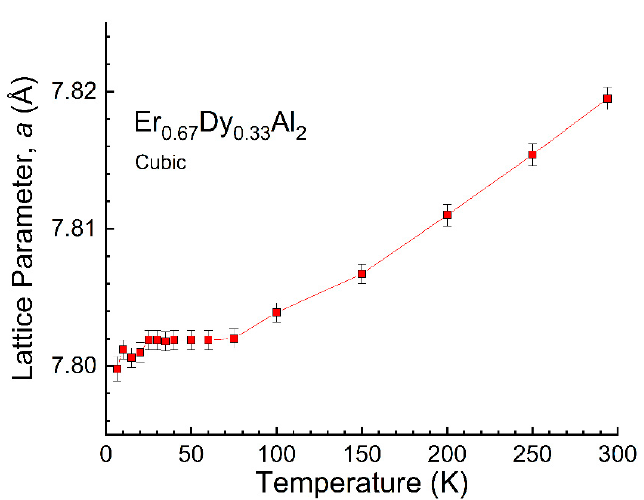
Figure 7. Lattice parameters of the Er 0.67 Dy 0.33 Al 2 as a function of temperature.